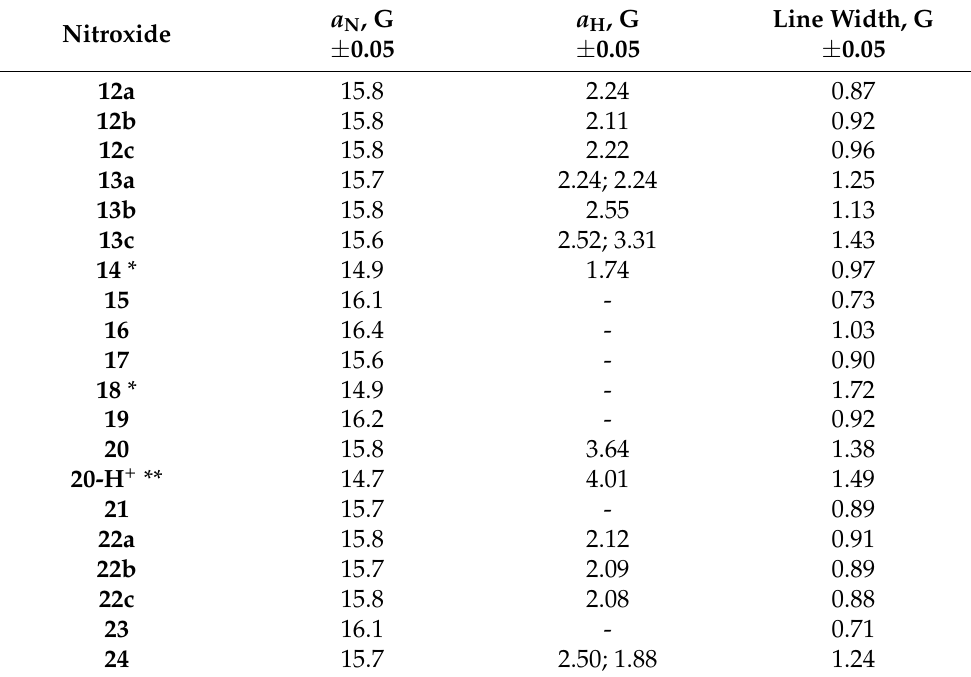
Table 2. Parameters of the EPR spectra of nitroxides in oxygen-free distilled water at a concentration of 0.2 mM. Modulation amplitude 0.5 G, MW power 5